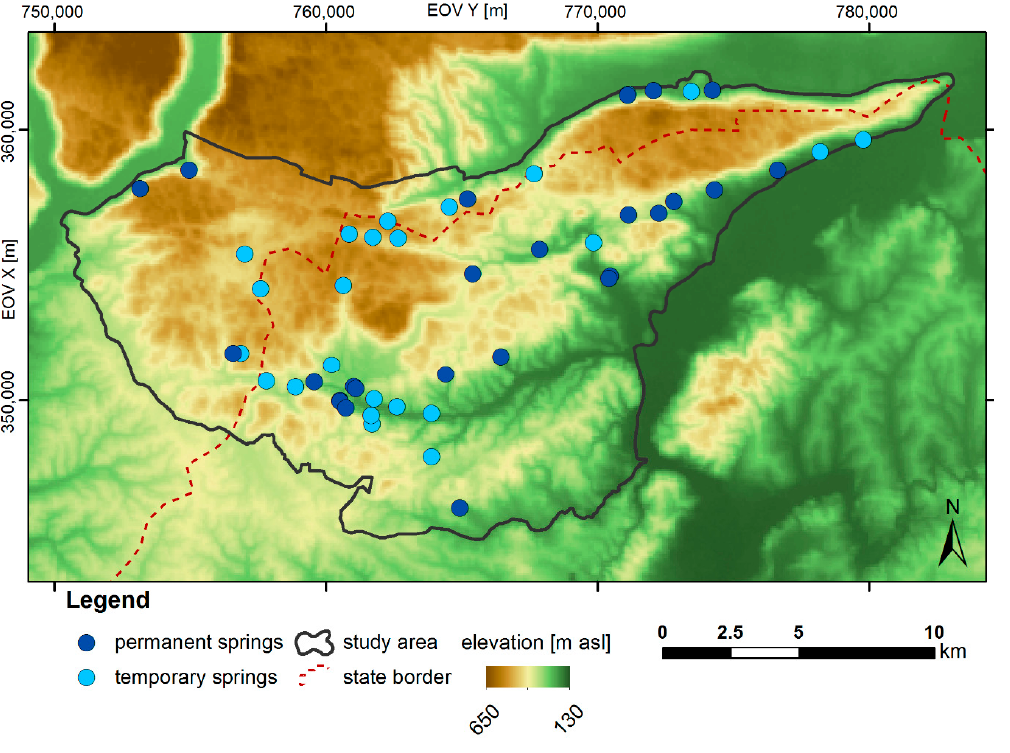
Figure 4. Response variables: location of permanent and temporary springs.